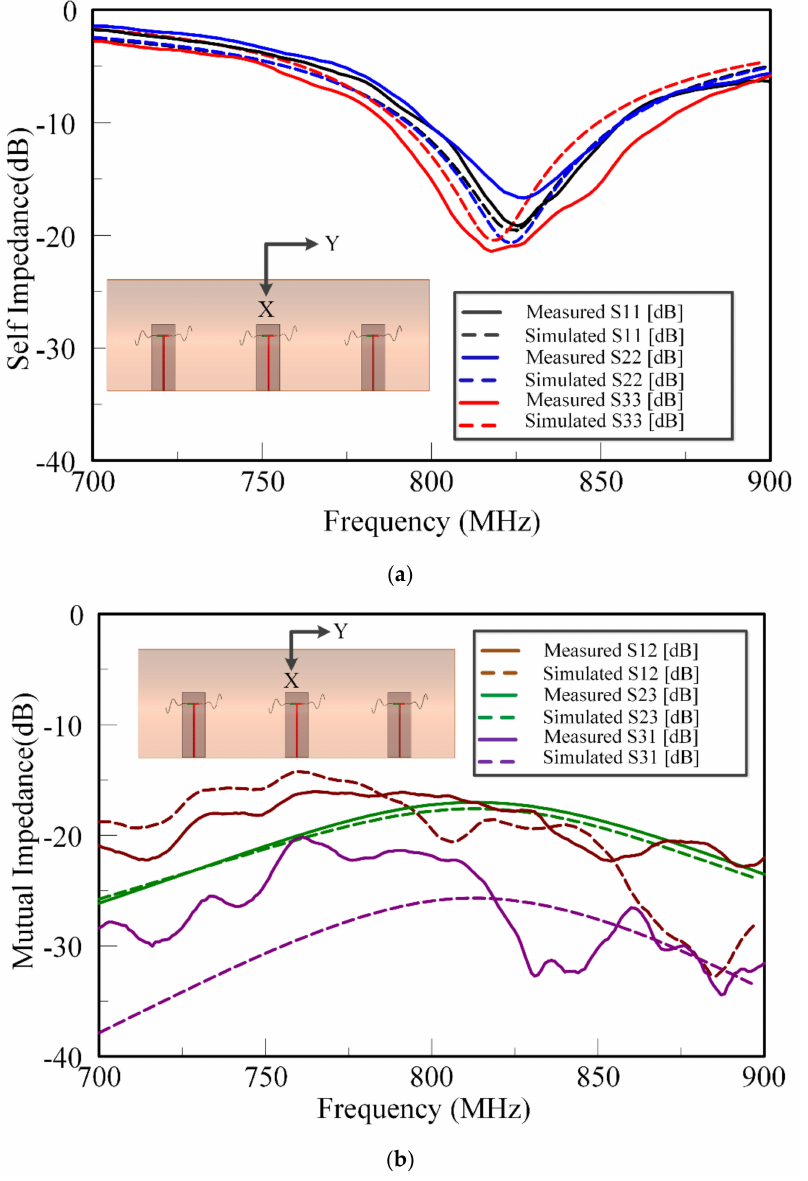
Figure 8. Measured and simulated impedance results of multi-element SEVACLA at 824 MHz for channel filling variable, t = 1.55 in ( a ) Self-impedance of the array elements ( b ) Mutual-impedance of array